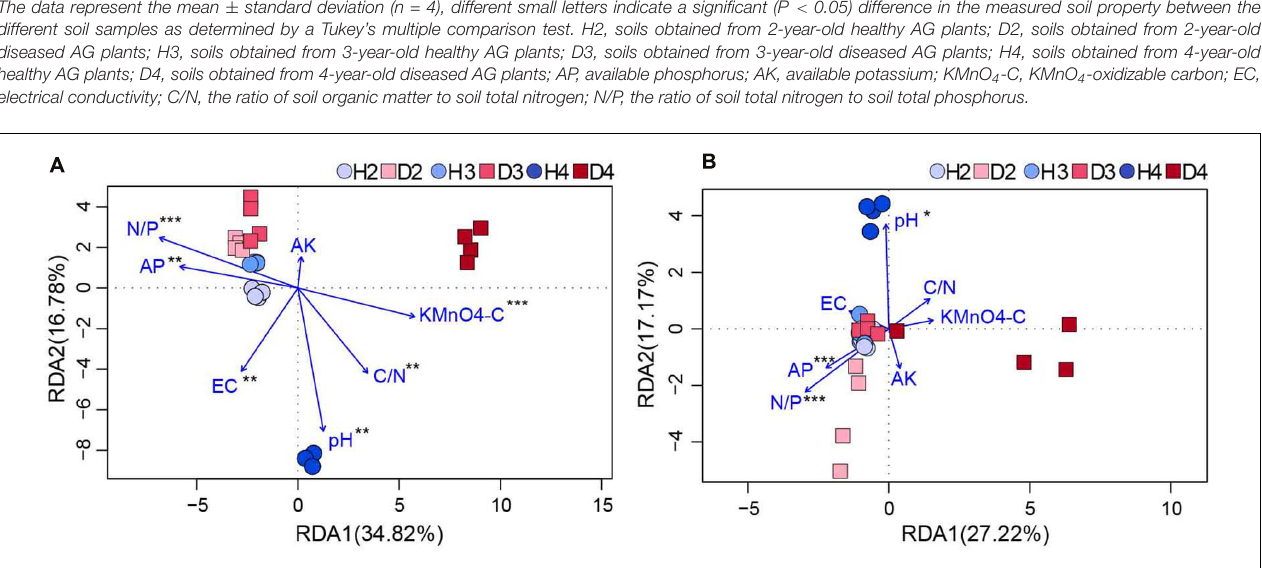
FIGURE 6 | RDA of the correlation between bacterial (A) and fungal (B) communities (OTU level) with physicochemical factors of the obtained soil samples (*0.01 < P ≤ 0.05, **0.5 < P ≤ 0.01, and ***0.01 < P ≤ 0.001. AP, available phosphorus; AK, available potassium; KMnO 4 -C, KMnO 4 -oxidizable carbon; EC, electrical conductivity; C/N, the ratio of soil organic matter to soil total nitrogen; N/P, the ratio of soil total nitrogen to soil total phosphorus). H2, soils obtained from 2-year-old healthy AG plants; D2, soils obtained from 2-year-old diseased AG plants; H3, soils obtained from 3-year-old healthy AG plants; D3, soils obtained from 3-year-old diseased AG plants; H4, soils obtained from 4-year-old healthy AG plants; D4, soils obtained from 4-year-old diseased AG